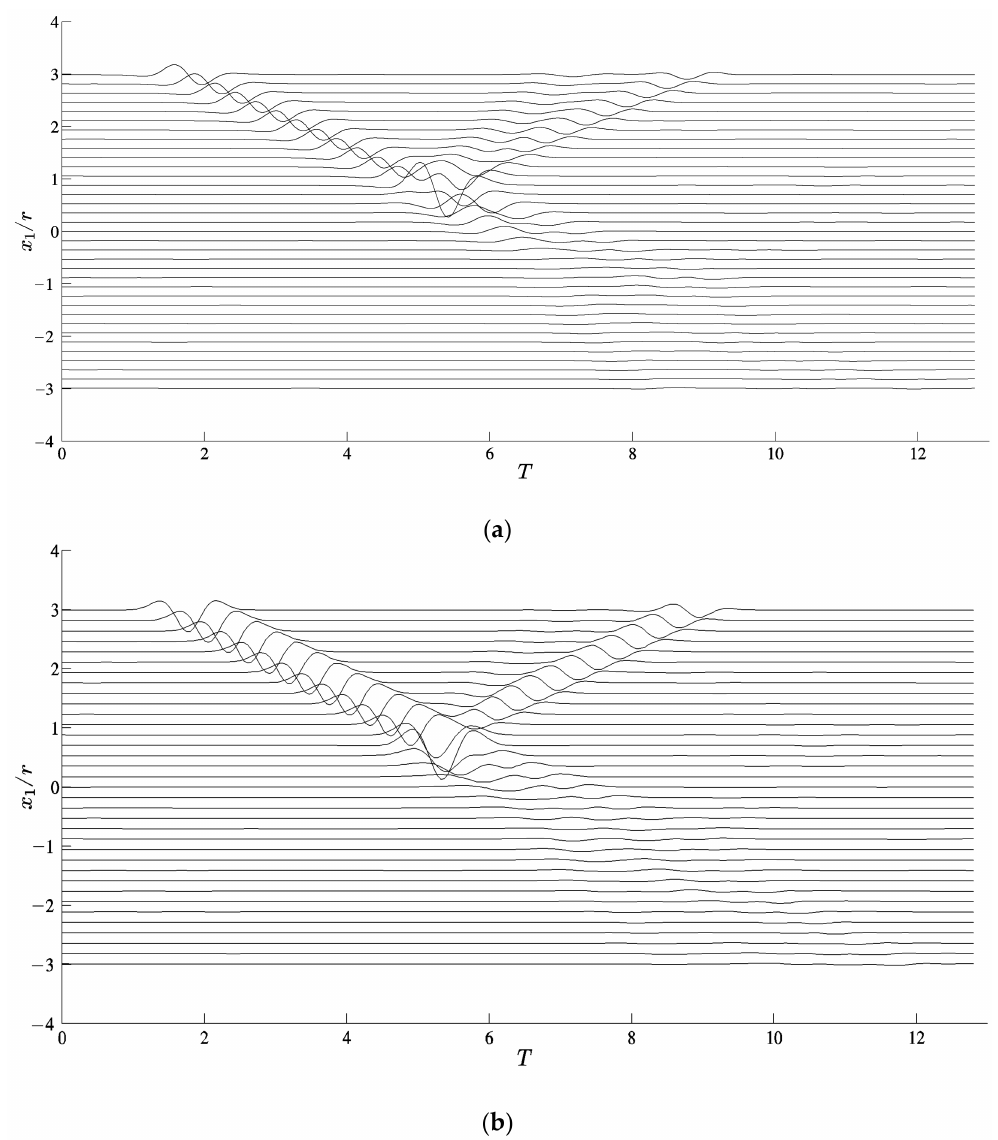
Figure 7. Displacement at different surface points in time-domain ( a ) x 1 component; ( b ) x 2